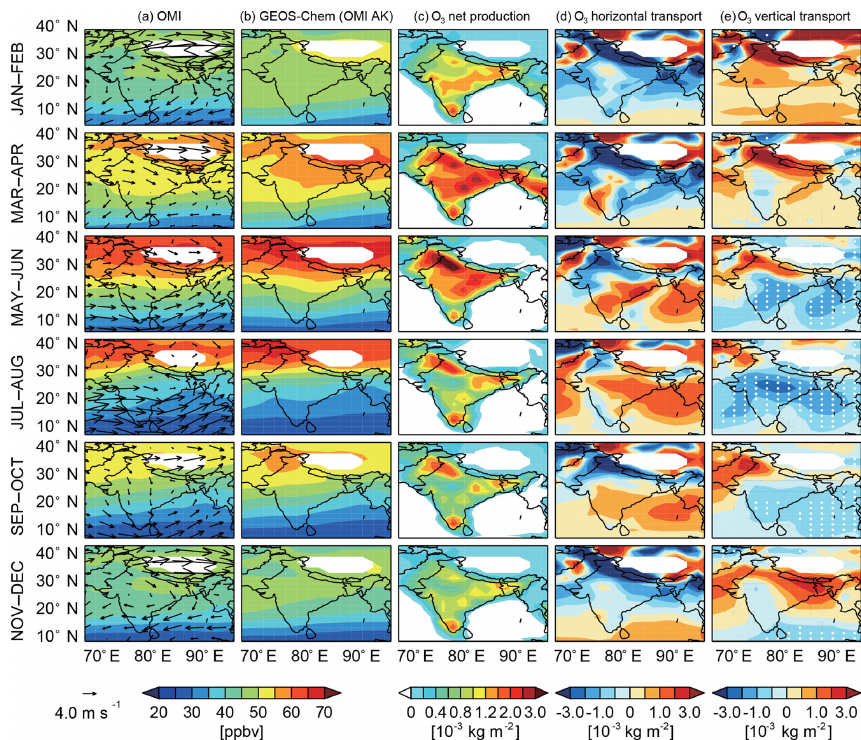
Figure 3. Spatial distributions of bimonthly mean lower tropospheric ozone from (a) OMI satellite observations and (b) GEOS-Chem model results (with OMI averaging kernel matrices and a priori profiles applied). Also shown are changes in lower tropospheric ozone burden contributed by (c) net chemical production, (d) net horizontal transport, and (e) vertical transport flux at 600hPa. All values are averaged for 2006–2010. Wind patterns are overlaid in (a) . White dots in (e) denote model grid cells where mean absolute vertical velocities at 600hPa exceed 5mms − 1